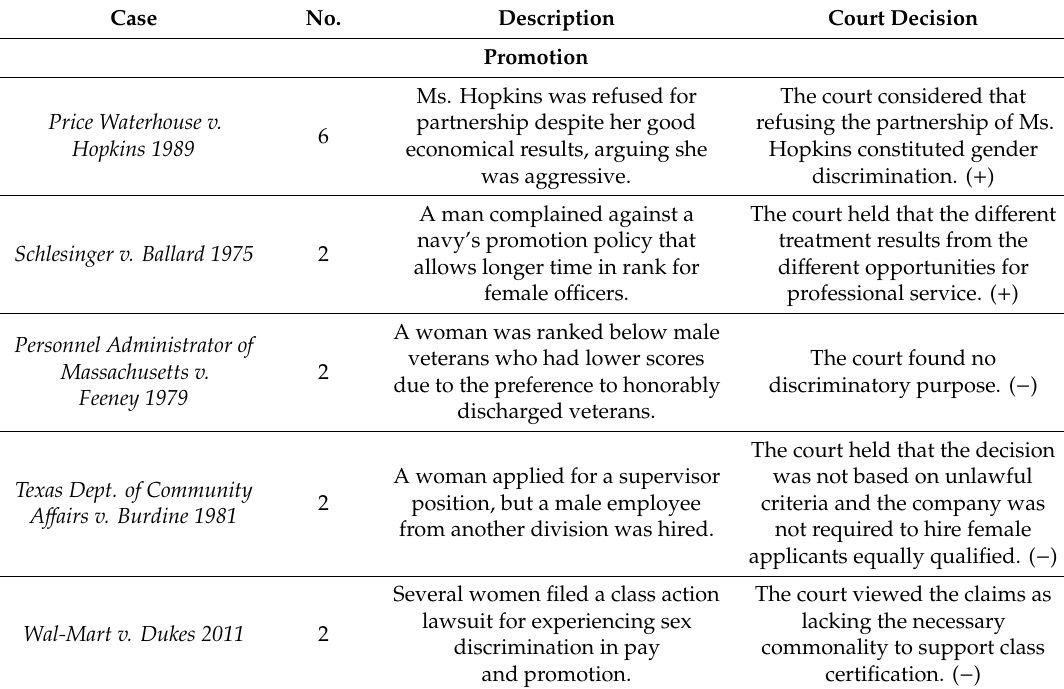
Figure 1. Systematic review flow charts. Table 1. Summary of North American lawsuit gender